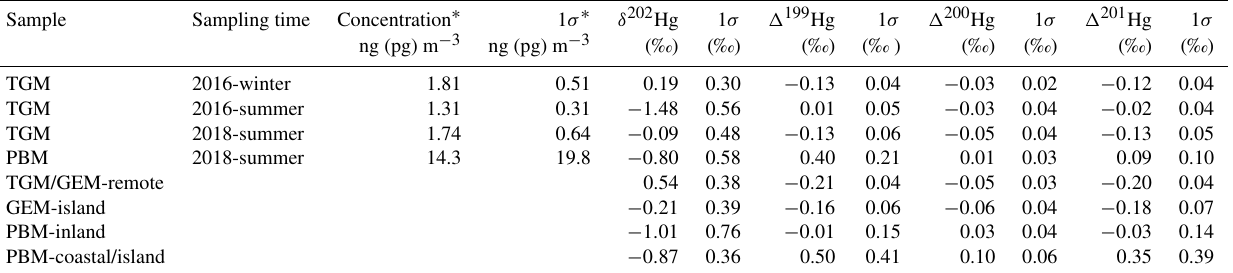
Table 1. Statistical summary table of isotopic data in this study. The comparison data from previous publications are characterized for TGM in remote areas (Demers et al., 2013, 2015; Fu et al., 2016, 2018; Yu et al., 2016), GEM in an island located in the East China Sea (Fu et al., 2018), PBM collected at inland sites (Yu et al., 2016; Das et al., 2016; Huang et al., 2015, 2016; Xu et al., 2017), and PBM collected in a coastal site in the USA (Rolison et al., 2013) and the same island in the East China Sea (Fu et al., 2019b). Sample